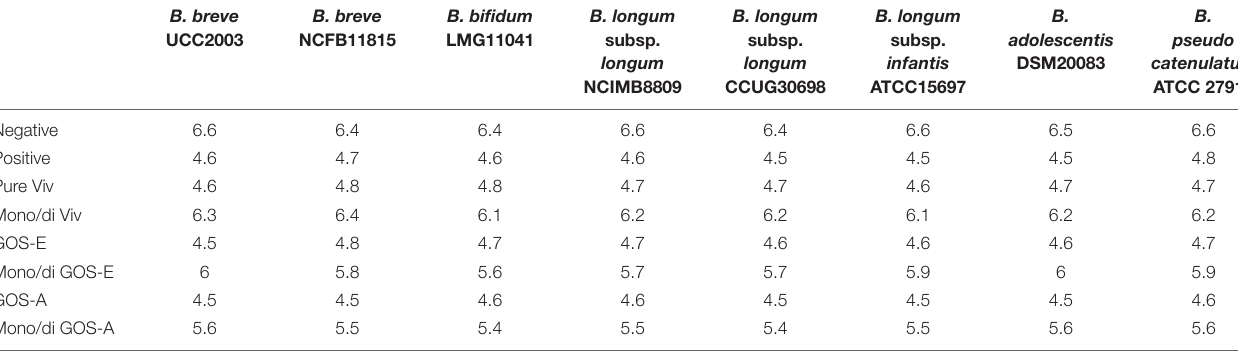
TABLE 7 | pH values following 24 h growth on Vivinal GOS, GOS-A, GOS-E and related mono/di Mix.